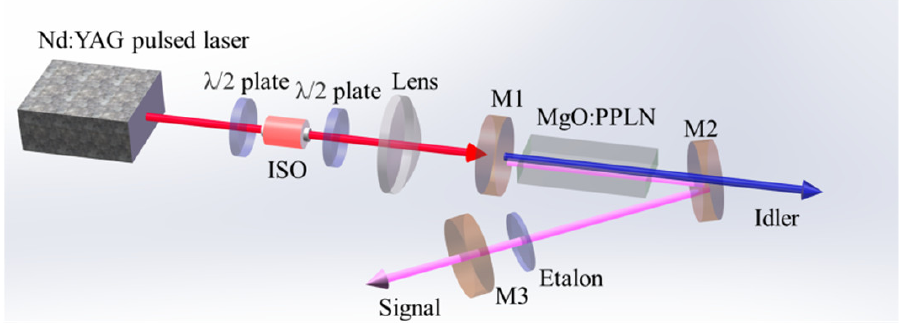
Table 1. To narrow the linewidth of the signal, a 0.35 mm-thick fused silica F–P solid etalon (R = 68% @1550 nm on both sides) is inserted into the single resonant cavity at a small